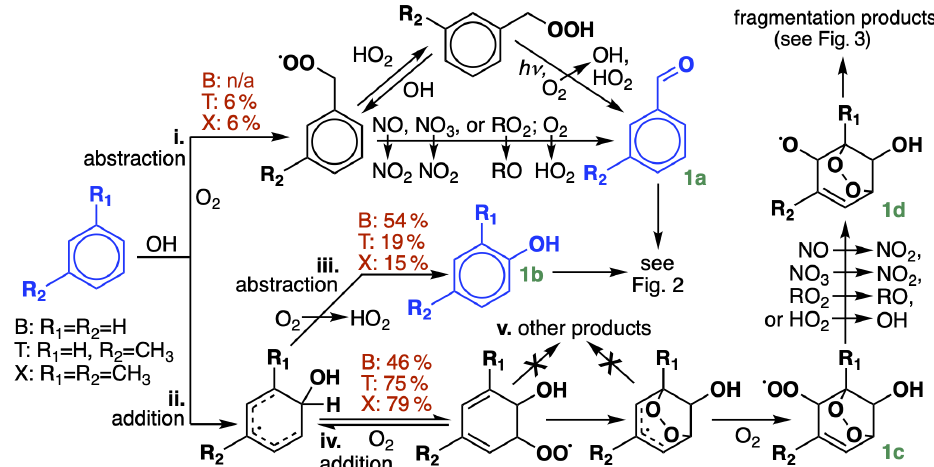
Figure 1. Initial oxidation chemistry of benzene, toluene, and xylenes. R 1 and R 2 denote either H or CH 3 , depending on the species. For simplicity, only m -xylene is shown; in GC13, the xylene isomers are lumped together. Initial branching ratios in GC13 are shown in red, and species treated explicitly and uniquely in the aromatic oxidation mechanism are highlighted in blue. n/a represents not applicable.